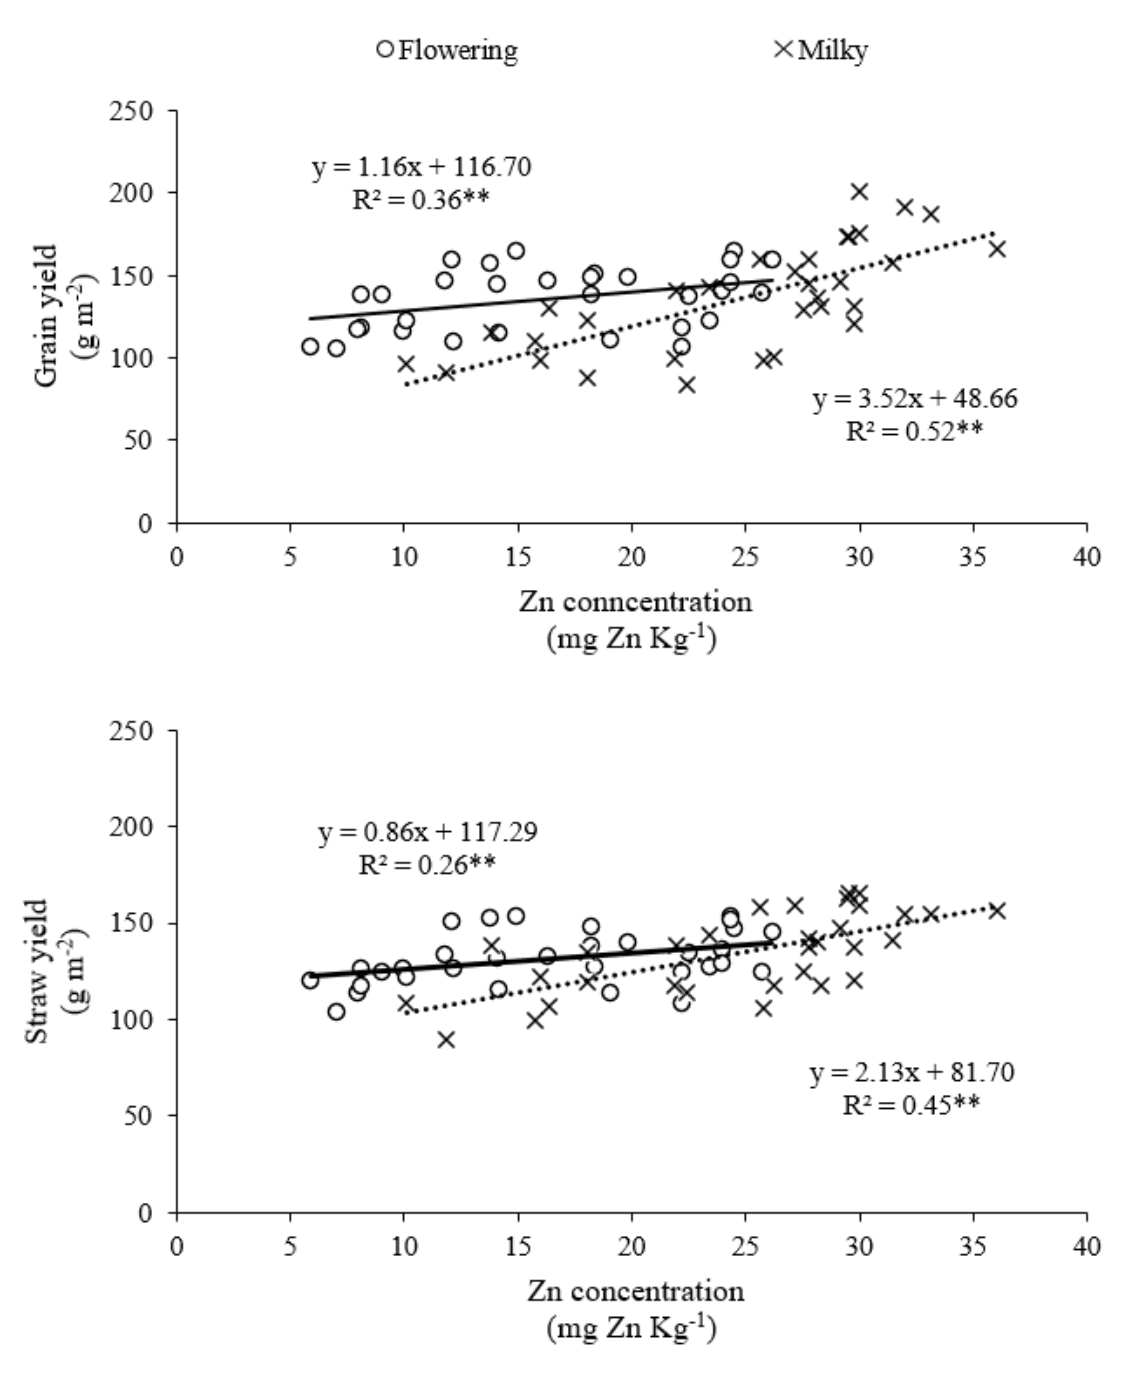
Figure 6 . The relationship between Zn concentration and grain yield, Zn concentration, and straw yield in the brown rice SPT1 variety grown at different foliar N and Zn fertilizer rates under variations of soil Zn fertilizer at the flowering and milky stages. ** indicates signification linear regression at p < 0.001 ( n = 32).